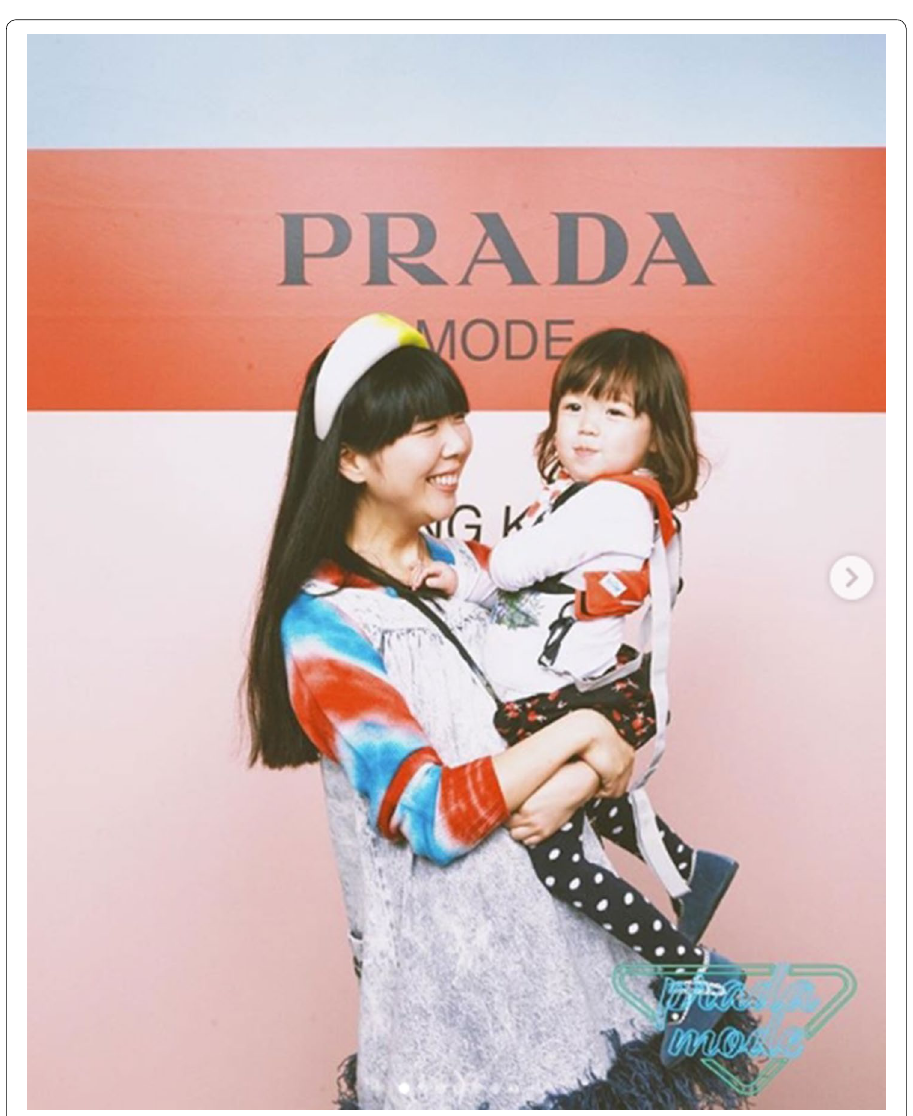
Fig. 9 Niko in Pradamode HK. https ://www.insta gram.com/p/Bvjn2 kEBTW J/. Accessed 20 September